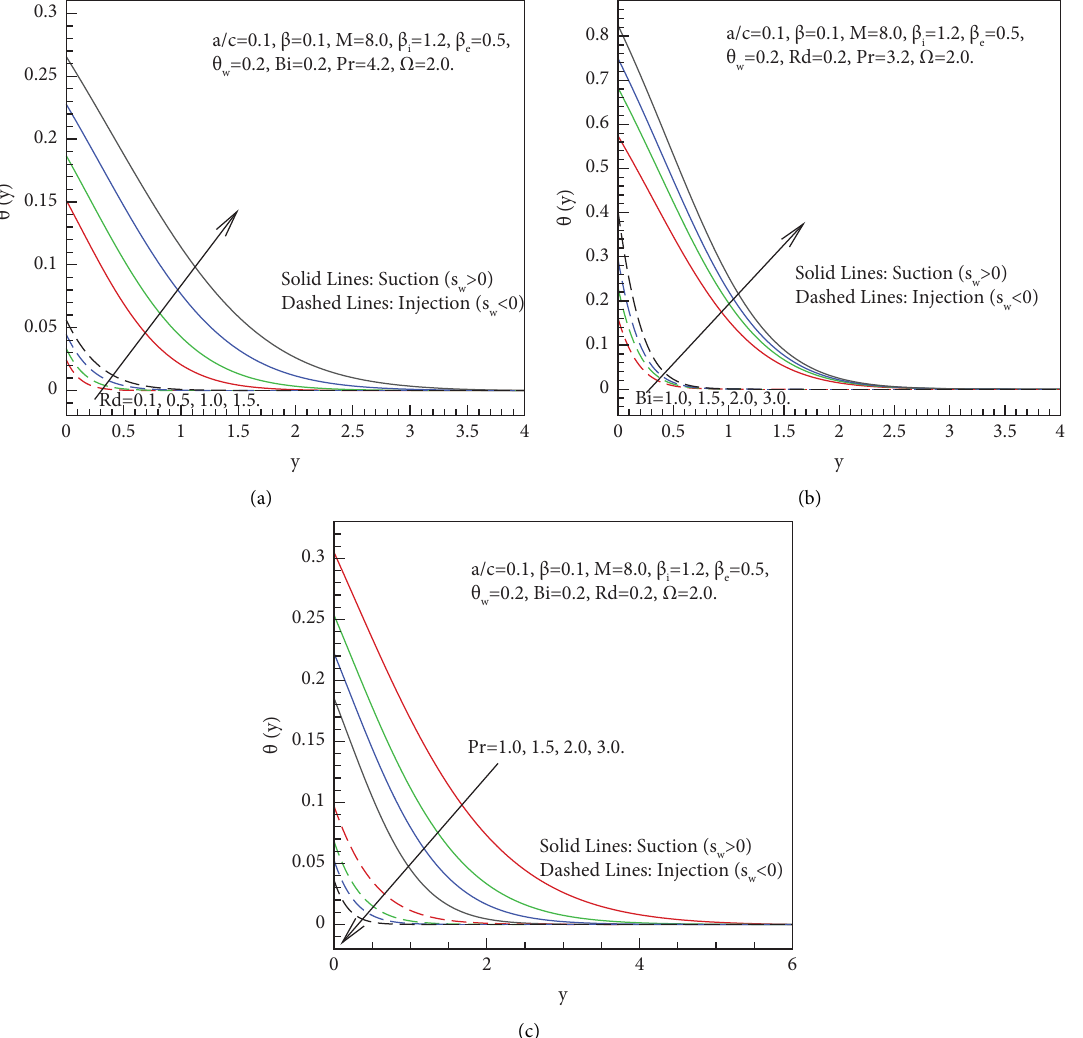
Figure 6: (a) Temperature distribution θ ( y ) for radiation parameter Rd , (b) temperature distribution θ ( y ) for Biot number Bi , and (c) temperature distribution θ ( y ) for Prandtl number